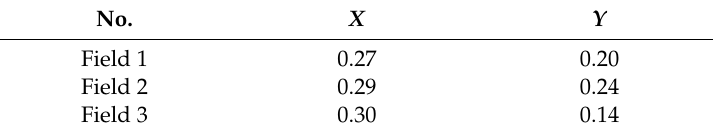
Table 11. Structure parameters of the main insulation system.